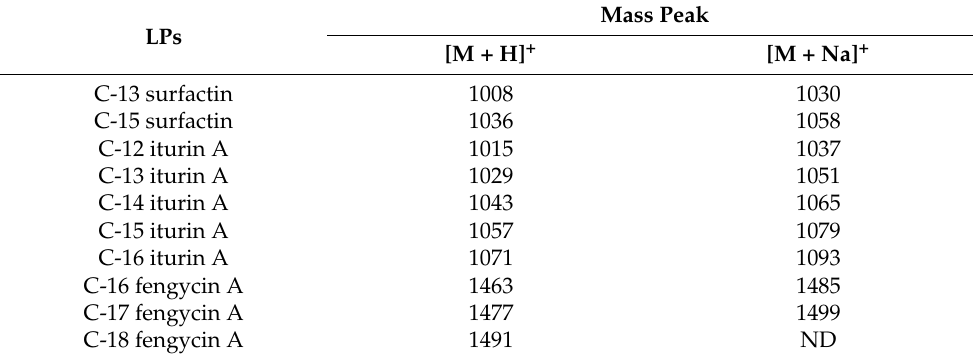
Table 2. Antifungal LPs identified after the LC/MS analysis of LP crude.